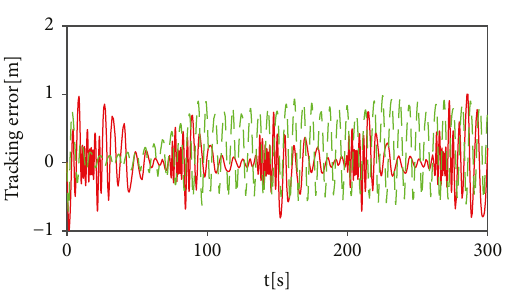
Figure 7: Position tracking trajectory.